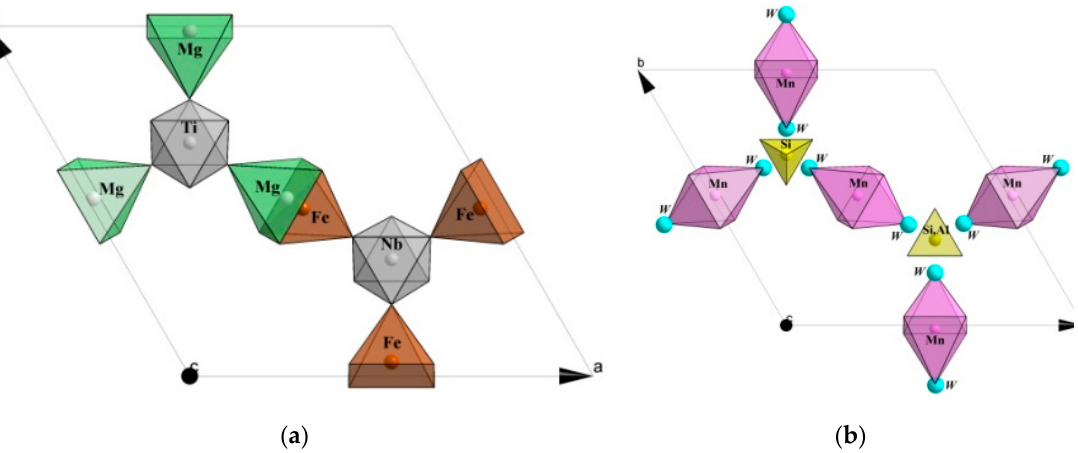
Figure 16. Alternative variants of blocky isomorphism in the structure of manganoeudialyte [58], with the M 2 micro-region occupied by differently oriented Mg- and Fe-centered square pyramids ( a ) and by Mn-centered octahedra ( b ) viewed along (001).